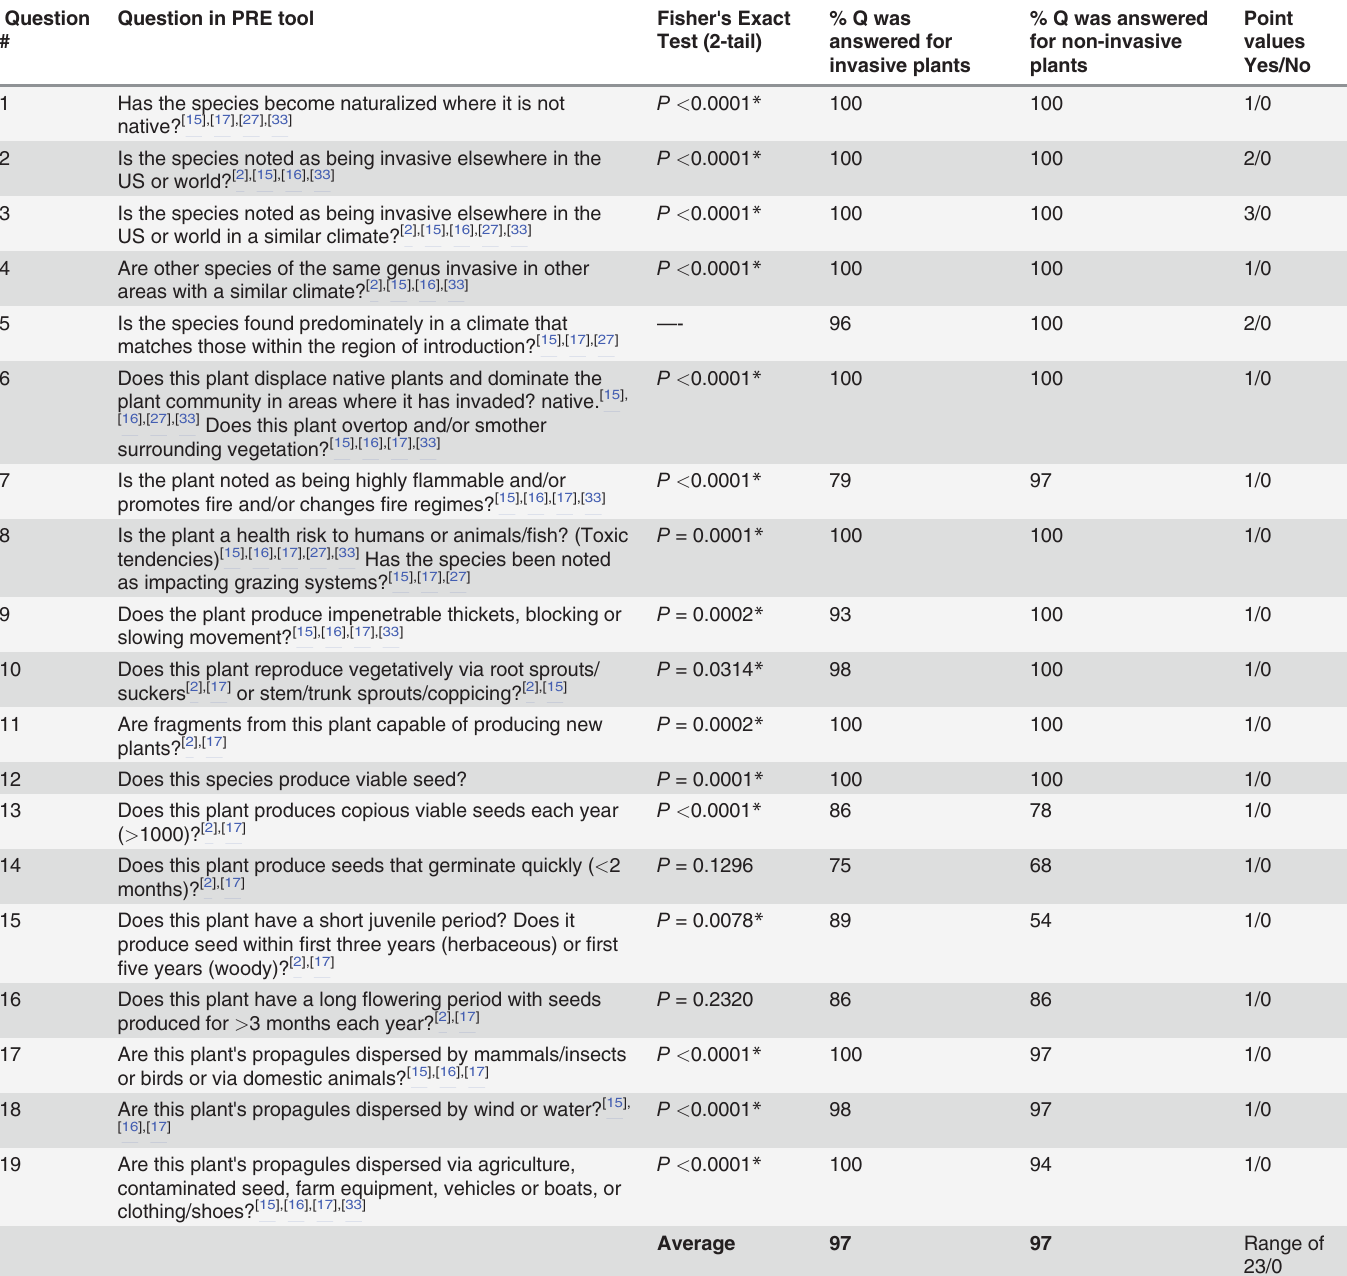
Table 2. PRE tool questions and their statistical predictability in separating known invasive and non-invasive species. Question